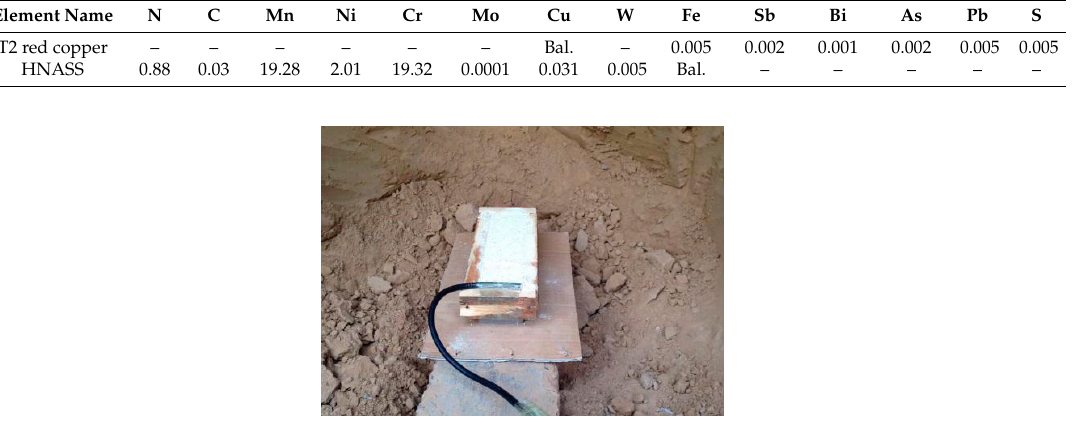
Figure 3. Explosive welding device. Table 3. Explosive welding parameters for different welding experiment.